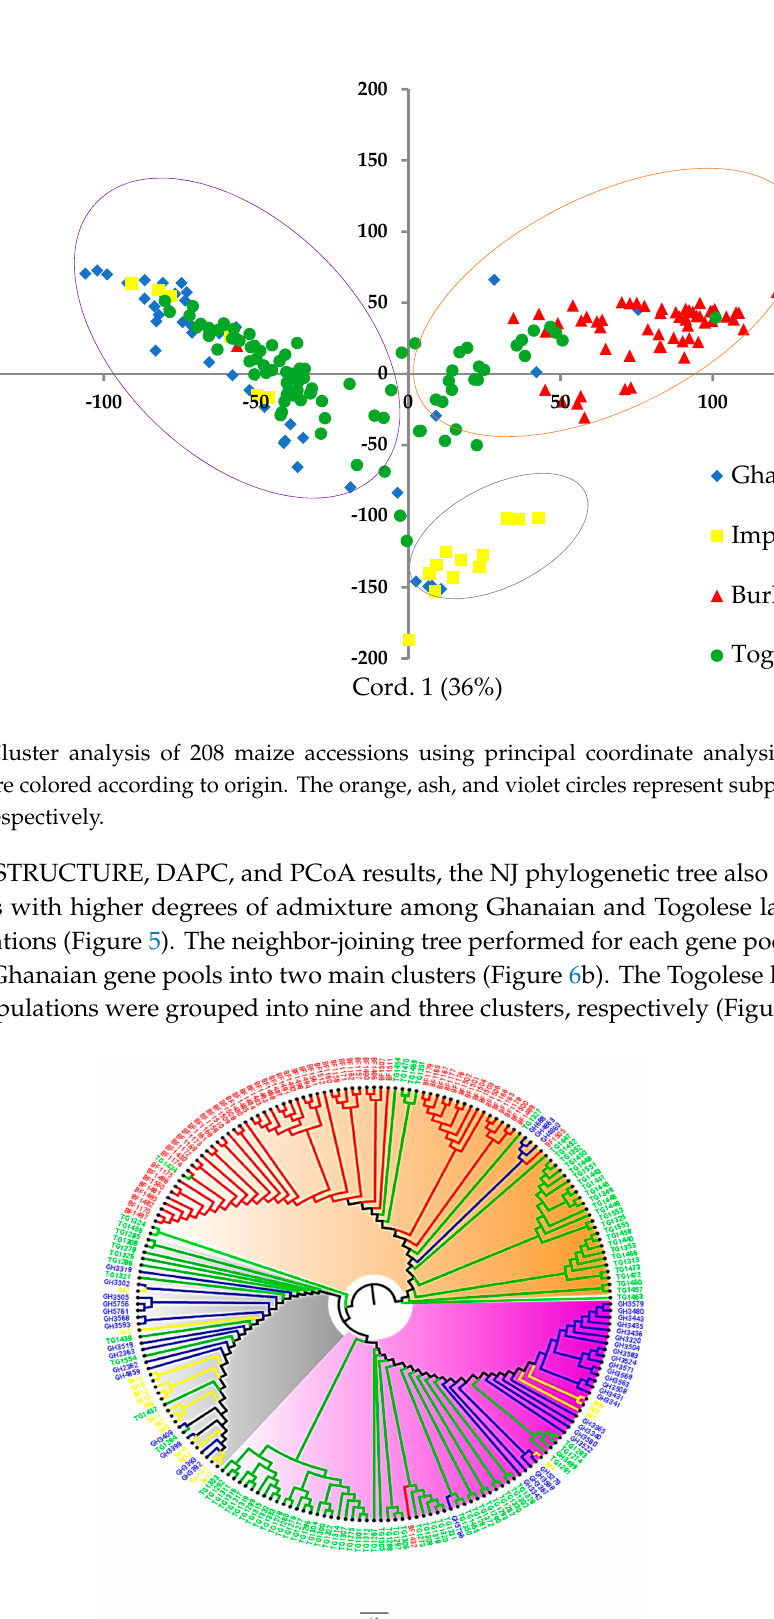
Figure 5. Phylogenetic tree estimated through the neighbor-joining method for 208 maize accessions from West Africa. The green, red, blue, and yellow clades and taxa represent Togolese, Burkinabe, Ghanaian, and reference populations, respectively. The orange, violet, and ash highlights represent subpopulations 1, 2, and 3,